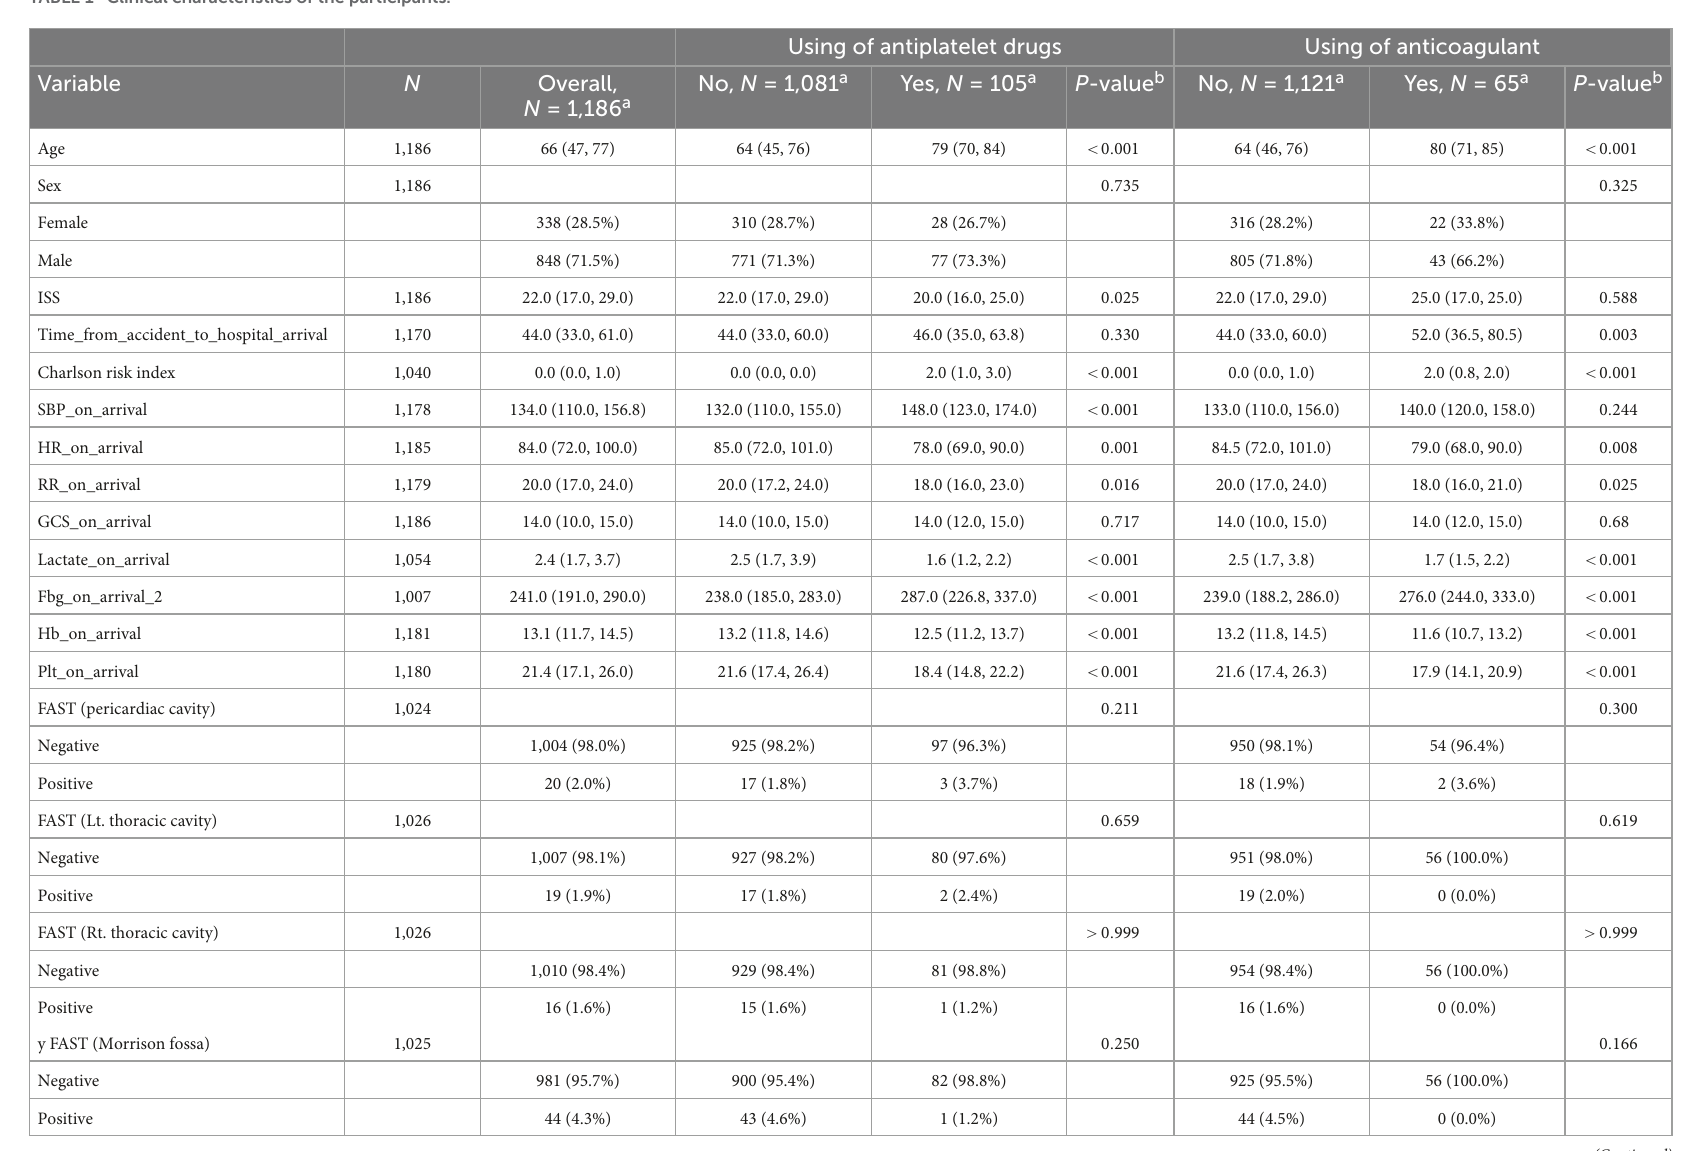
TABLE 1 Clinical characteristics of the participants.